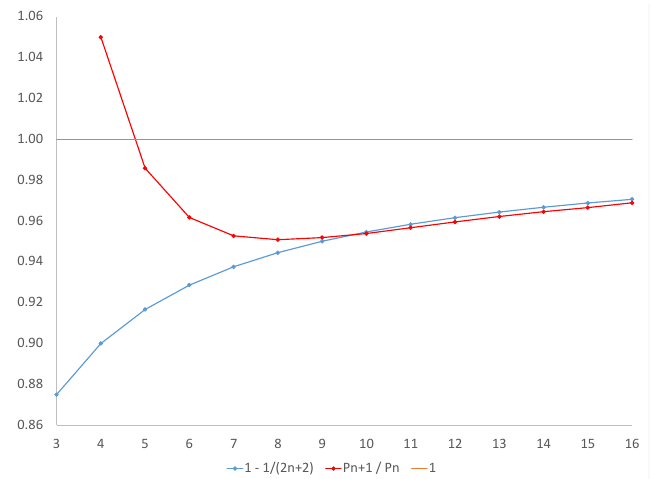
Figure 6. Representation of the convergence between successive probabilities, as n increases. (Prop- erty #